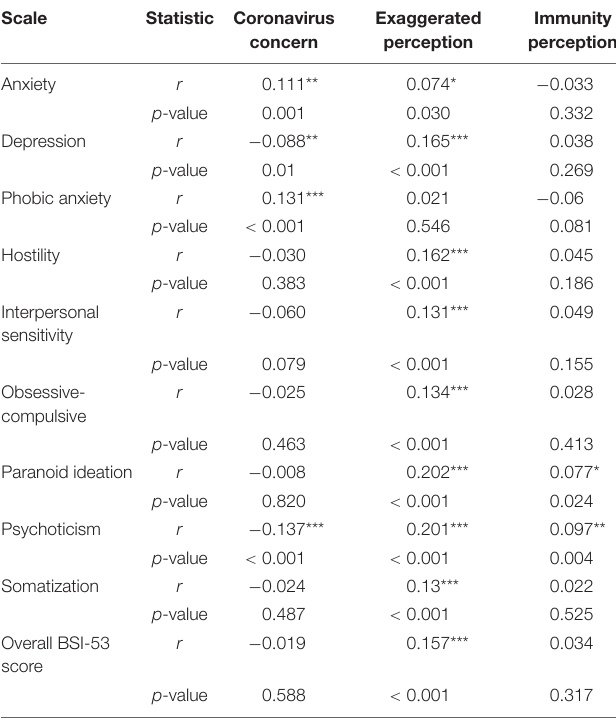
TABLE 5 | Correlation between CAS-10 and BSI-53 subscales.